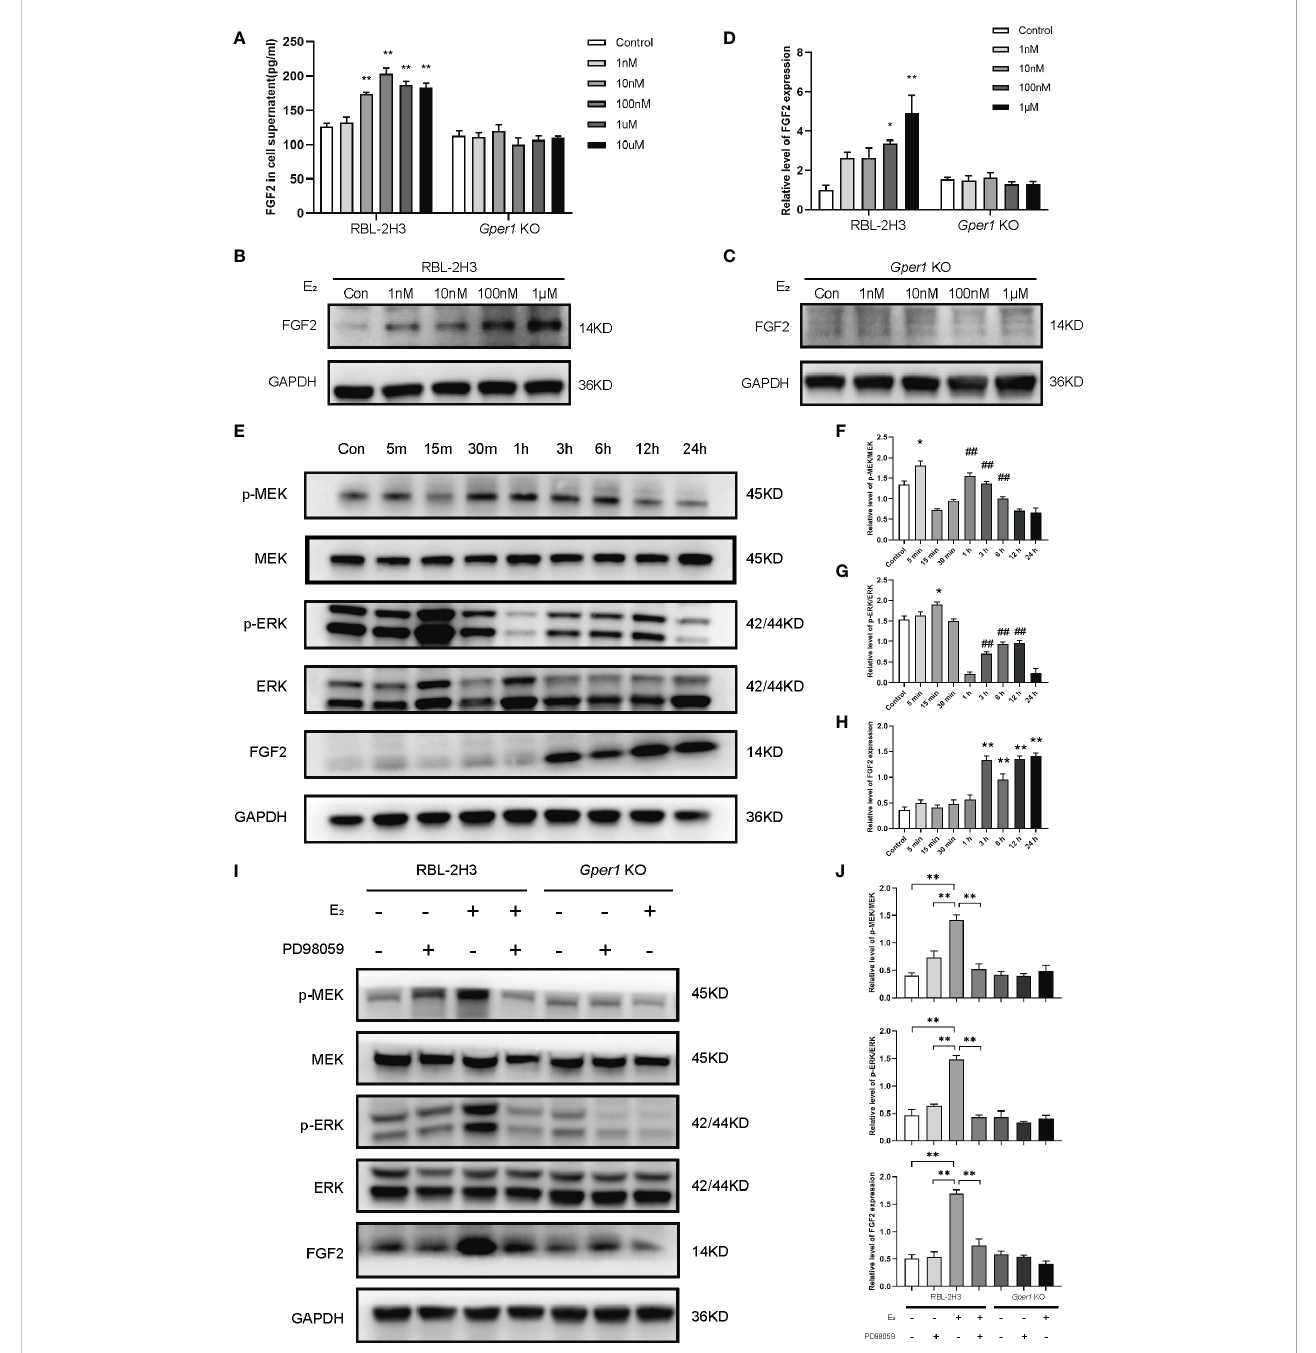
FIGURE 3 Upregulated FGF2 in mast cells depends on the activation of GPR30/p-MEK/p-ERK signaling pathway. (A) Contents of FGF2 in the supernatant of mast cells after intervention with different concentrations of estrogen. (B) Protein expression of FGF2 in RBL2H3 cells after intervention with different concentrations of estrogen. (C) Protein expression of FGF2 in Gper1 KO RBL2H3 cells after intervention with different concentrations of estrogen. (D) Relative expression of FGF2 protein in two mast cells after intervention with different concentrations of estrogen. (E) Western blot analysis of p-MEK, MEK, p-ERK, ERK, and FGF2 in mast cells after estrogen (100 nM) treatment at various timepoints. (F) Relative level of p-MEK/MEK in mast cells after estrogen (100 nM) treatment at various timepoints. * P < 0.05 (5 min vs. Control), ## P < 0.01 (1, 3, 6 h vs. 15 min). (G) Relative level of p-ERK/ERK in mast cells after estrogen (100 nM) treatment at various timepoints. * P < 0.05 (15 min vs. Control), ## P < 0.01 (1, 3, 6, 12 h vs. 1 h). (H) Relative expression of FGF2 in mast cells after estrogen (100 nM) treatment at various timepoints. ** P < 0.05 (3, 6, 12, 24 h vs.